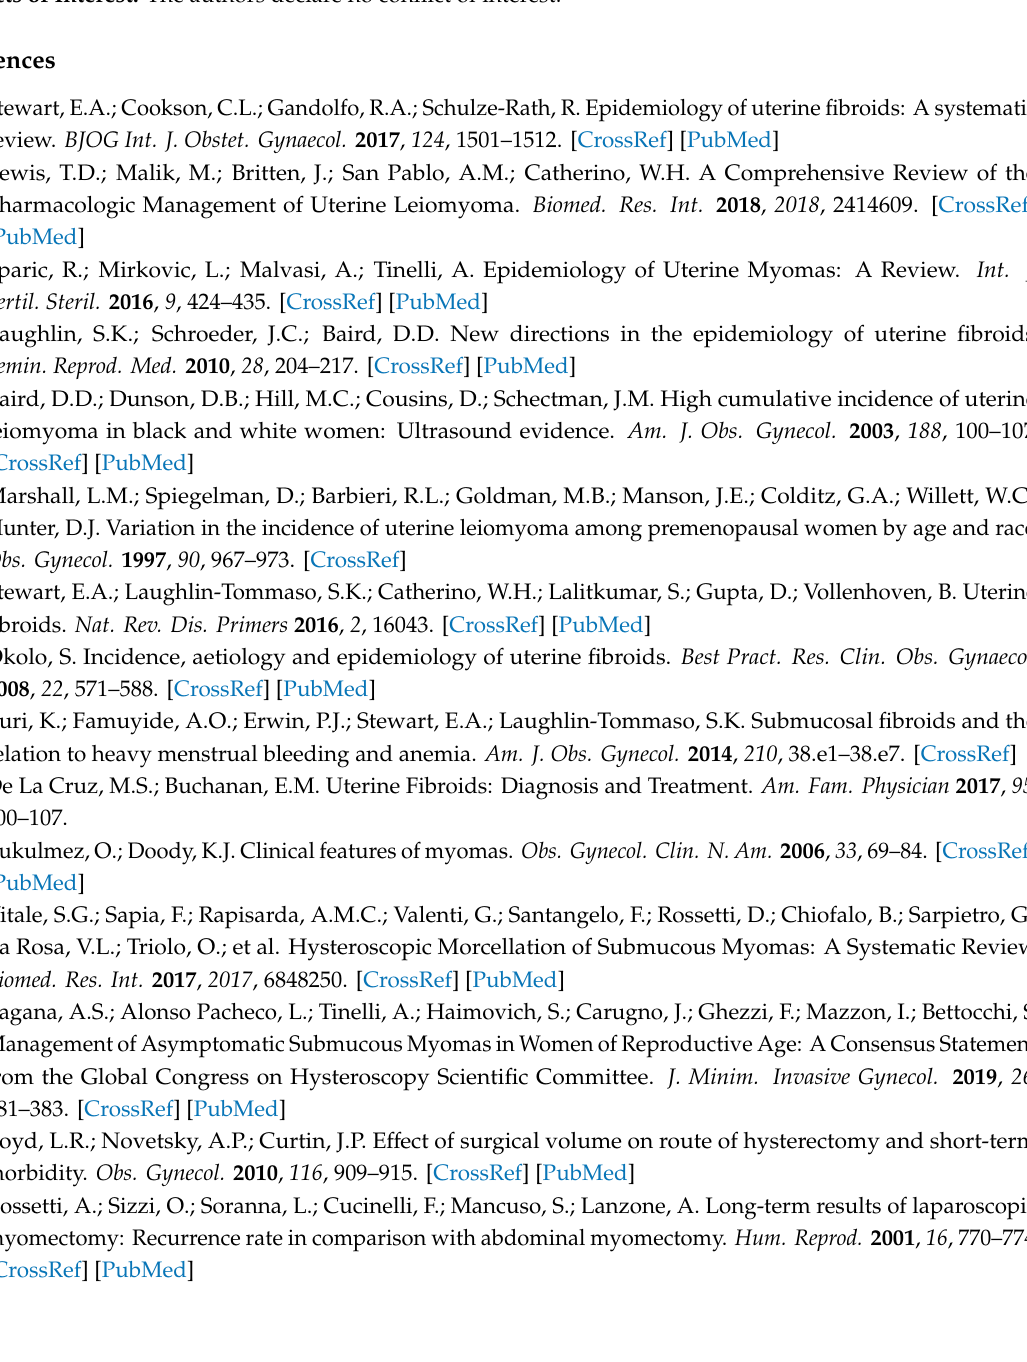
Figure S1: ISL treatment induced DNA damage in ELT3 cells, Figure S2: ISL treatment decreased the expression of ECM-associated